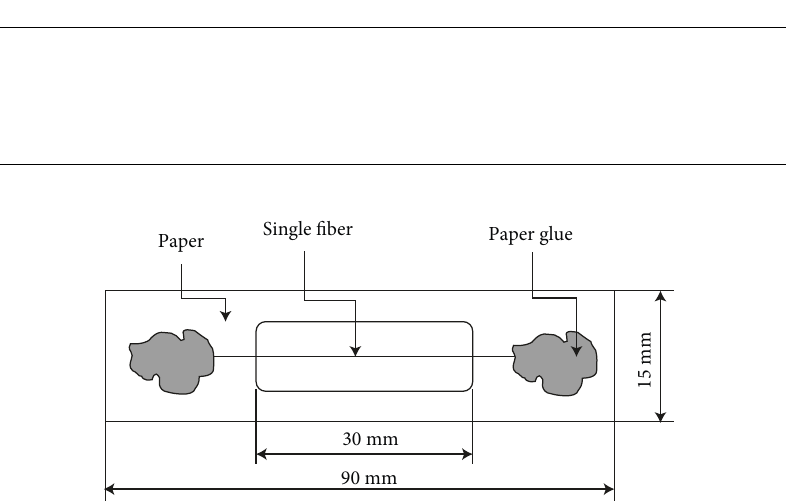
Figure 1: KPLF single fiber tensile test specimen.